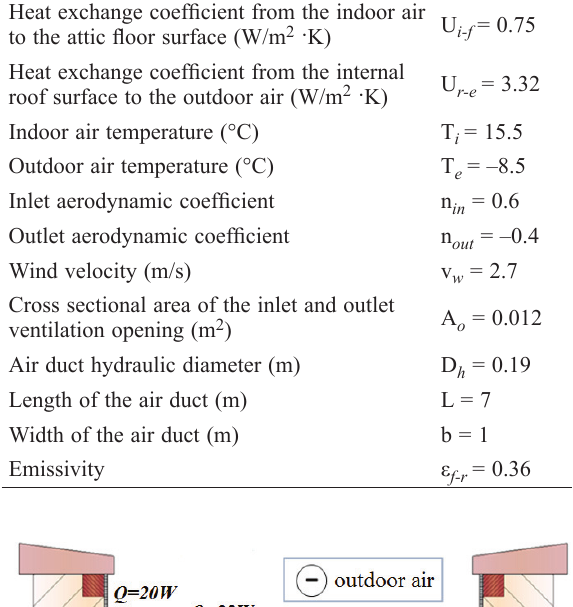
Table 1. Initial data for comparative calculations of attic space (according to Fokin) Heat exchange coefficient from the indoor air to the attic floor surface (W/m 2 ·K)